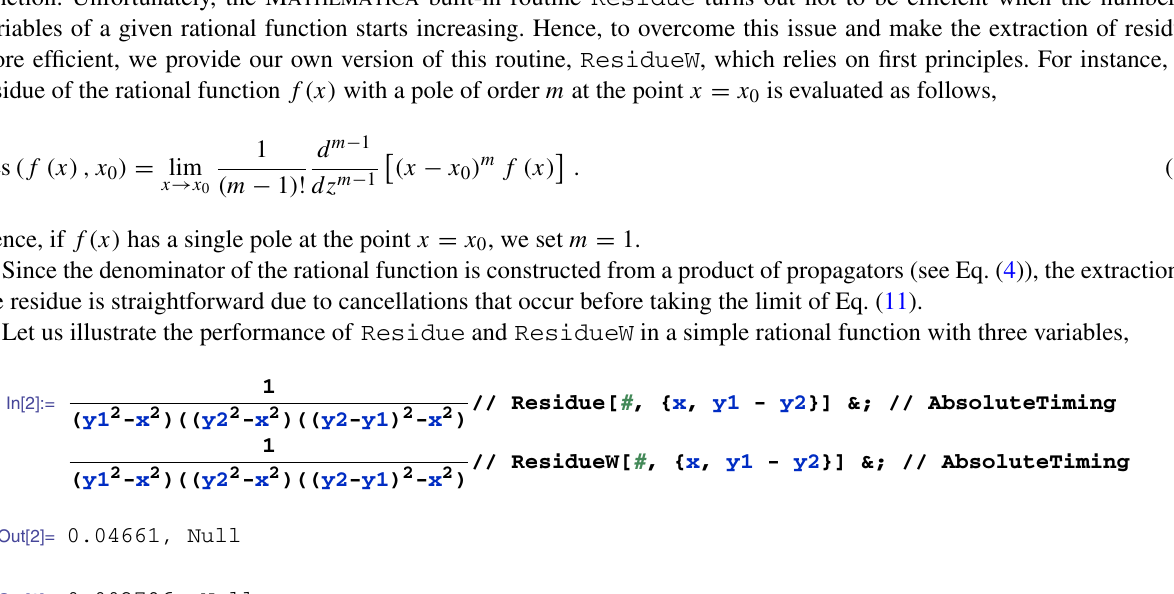
number. Assuming one is interested in parallelising, the user has to provide the number of kernels on which Lotty is going to be loaded. A naive choice of the latter, using the complete functionality of the computer, is setting $LottyKernels = 2$ProcessorCount